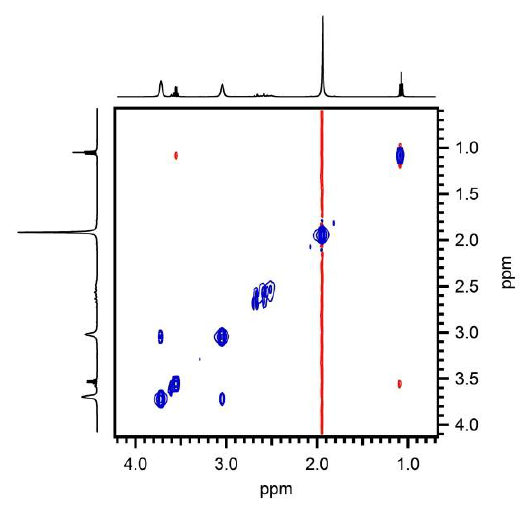
Figure 4. 2D NOESY spectrum of solution A microwave treated at 150 °C during 30 min after purification and the addition of CA and EA. Positive and negative NOE cross-peaks appear in red and blue and are attributed to their respective